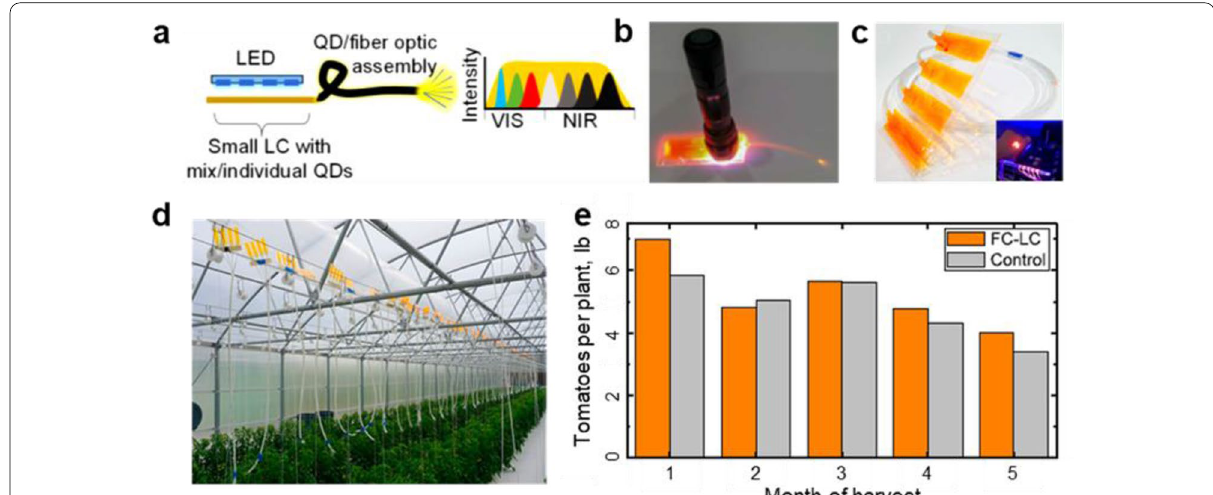
Fig. 6 a Schematic illustration of a fiber-coupled broadband light source. Quantum dots (QDs) are incorporated into small fiber-coupled luminescent concentrators (FC-LCs). b Photographs of a fiber-coupled luminescent concentrator with peak emission at 590 excited by a blue LED flashlight. c Photographs of the prototype FC-LCs devices for agricultural deployment. The inset depicts emissions during exposure to large-area blue LED lighting. d 82 collectors arrayed over a row of tomato plants in a commercial greenhouse. e Total harvested tomato weight (per plant) each month from the plants grown with and without FC-LCs. Reproduced with permission from